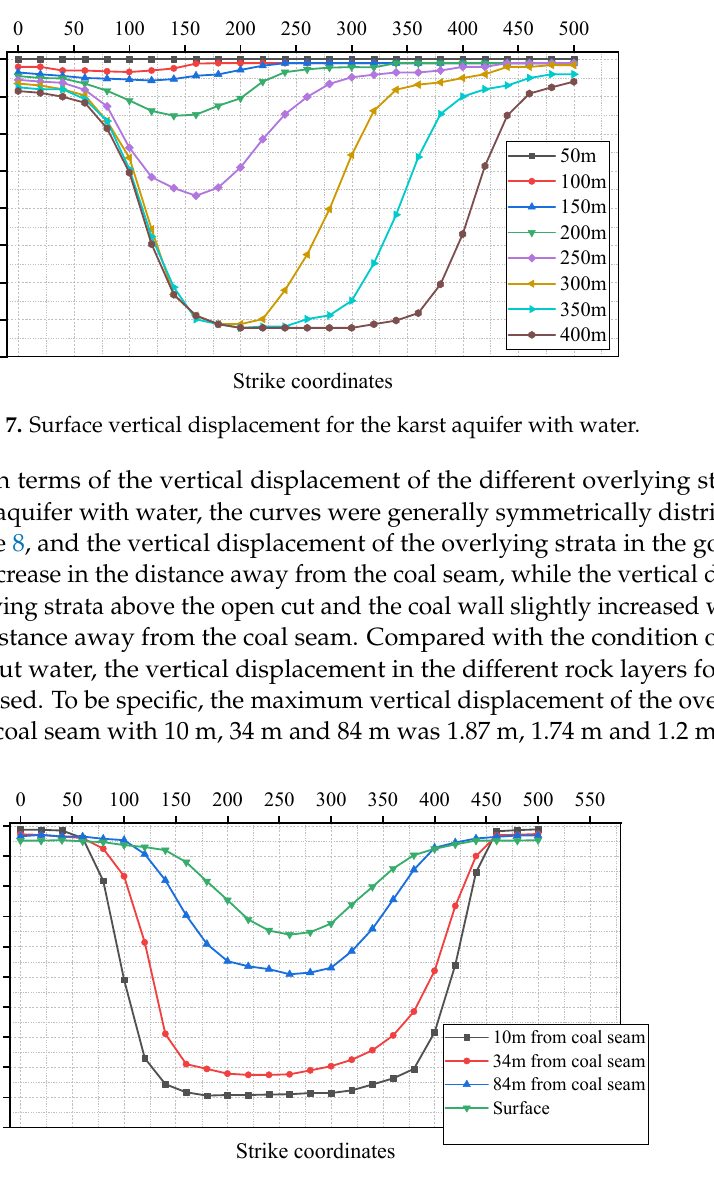
Figure 8. Vertical displacement of different overlying strata layers for the karst aquifer with water.